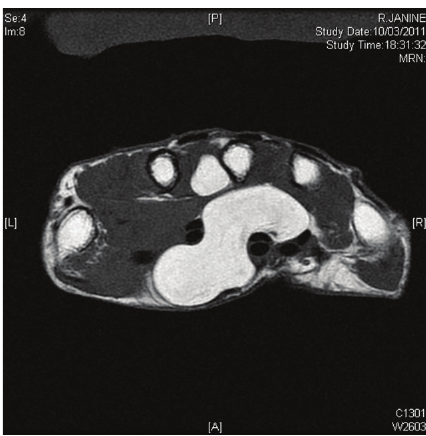
Figure 1: MRI axial view showing the tumor with spontaneous hypersignal rejecting flexors tendons without invasion.